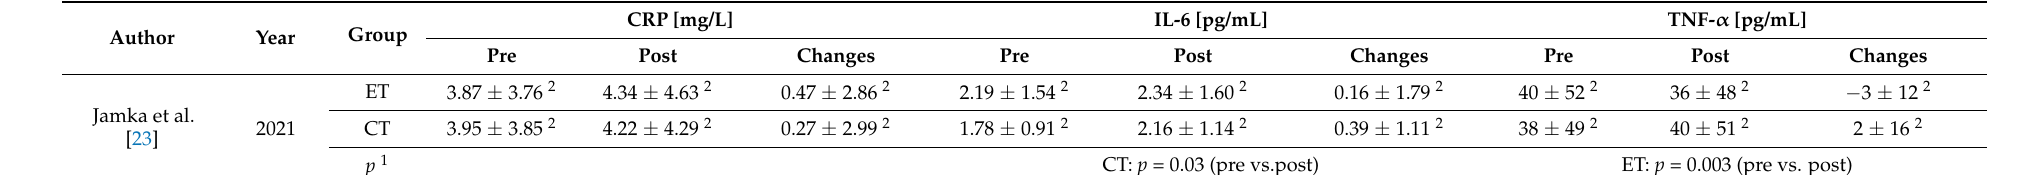
Table 3. Inflammatory parameters levels in studied